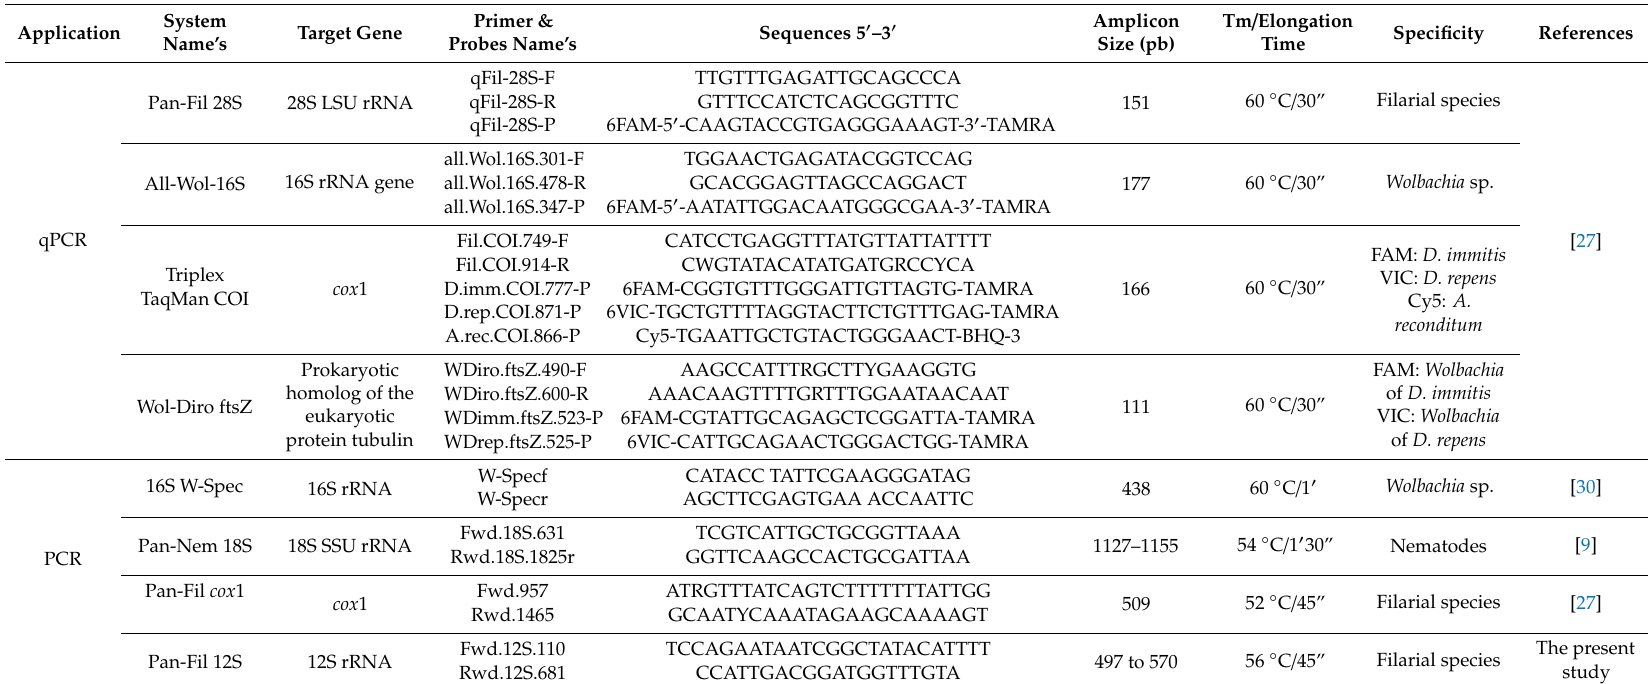
Table 1. Primers and probes used in this